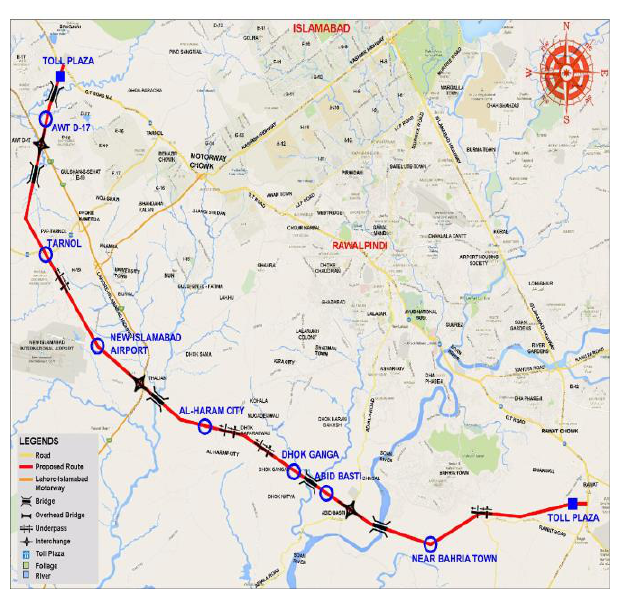
Figure 3: Alignment # 2 for the proposed Rawalpindi Bypass (51